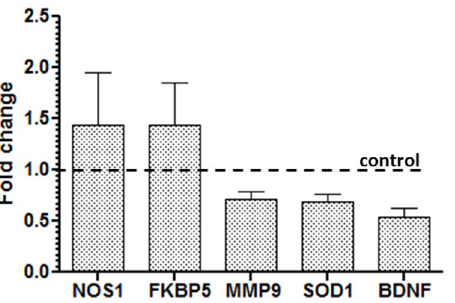
Figure 5. Genomic regulation of five genes associated with physiological stress ( NOS1 , FKBP5 , MMP9 , SOD1 and BDNF ) validated by real-time PCR assay. The bar graph shows the genomic fold changes (FD-fed/SD-fed mice) with 6 SEM. The horizontal line represents the control line depicting the fold change due to FD